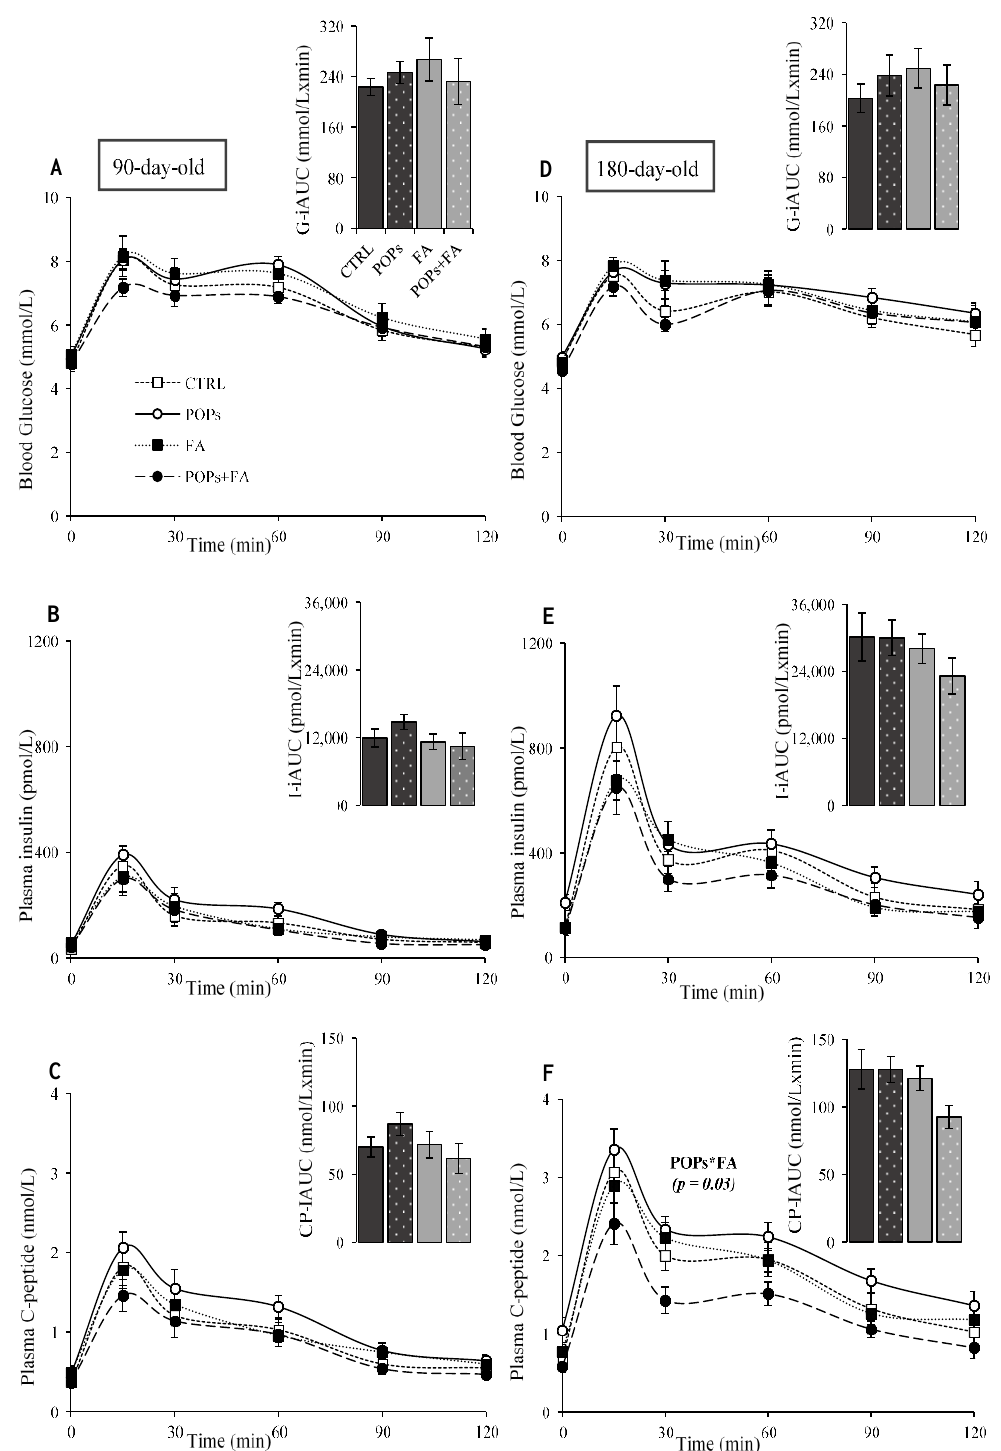
Figure 5. Impact of POP exposure and/or FA supplementation of F0 female rats on blood glucose, plasma insulin and C-peptide during a glucose tolerance test in F3 male rats aged 90 days ( A – C ) and 180 days ( D – F ). The histogram shows IAUC values. Results are expressed as mean ± SEM (n = 9 or 10). Two-way ANOVA with repeated measurements was used to compare time points within groups. ANOVA for a 2 × 2 factorial experiment was used to analyze the POPs and FA main effects and the POPs*FA interaction.